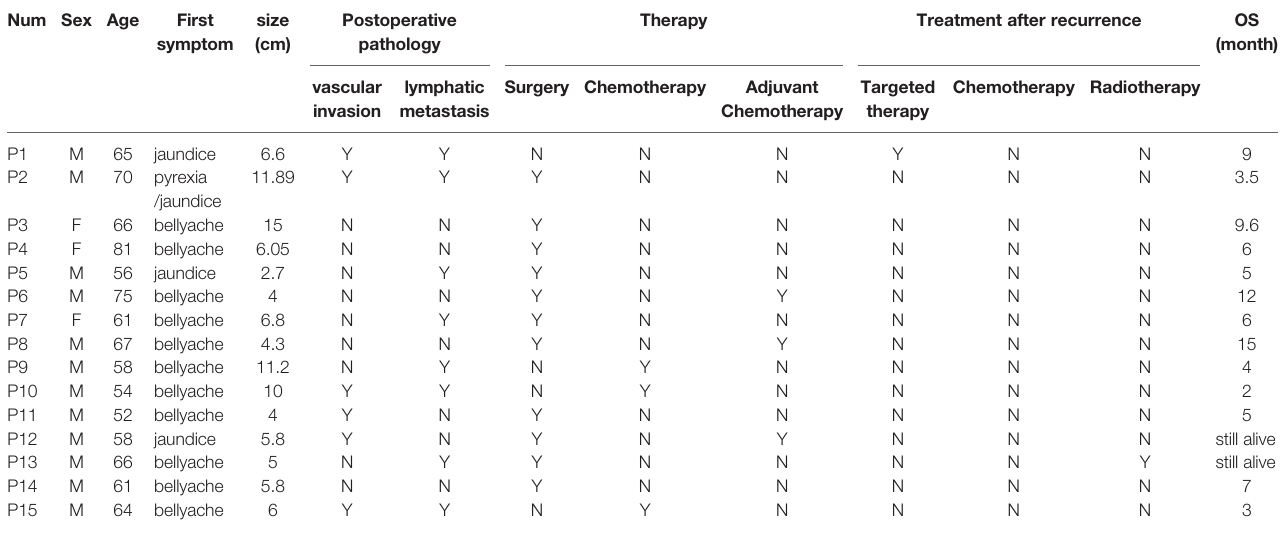
TABLE 1 | Clinicopathologic information of 15